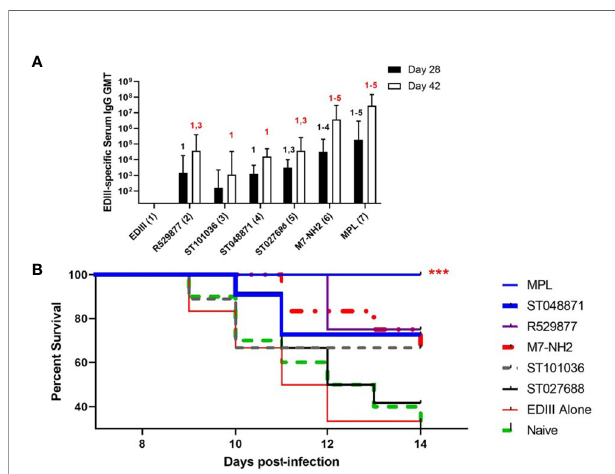
FIGURE 6 | Small molecule mast cell activators provide nasal adjuvant activity when co-administered with WNV EDIII and enhance survival after the WNV challenge. Female BALB/c mice were nasally immunized with EDIII alone (n=12) or combined with R529877 (n=12), ST101036 (n=9), ST048871 (n=11), ST027688 (n=12), M7 (n=12), or MPL (n=13). Vaccines were administered on days 0, 7, and 21 with antigen combined with adjuvant and again on day 35 with antigen only. Serum collected after three and four vaccine doses was measured for EDIII- speci fi c IgG (A) . One-way ANOVA with Tukey ’ s multiple comparisons was used to